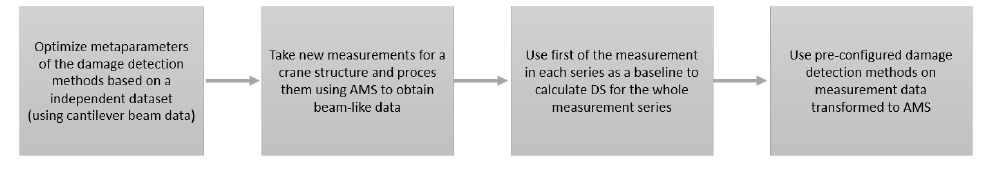
Figure 15. L-shape crane images captures in experiments: ( a ) front camera view, ( b ) side-front camera view.